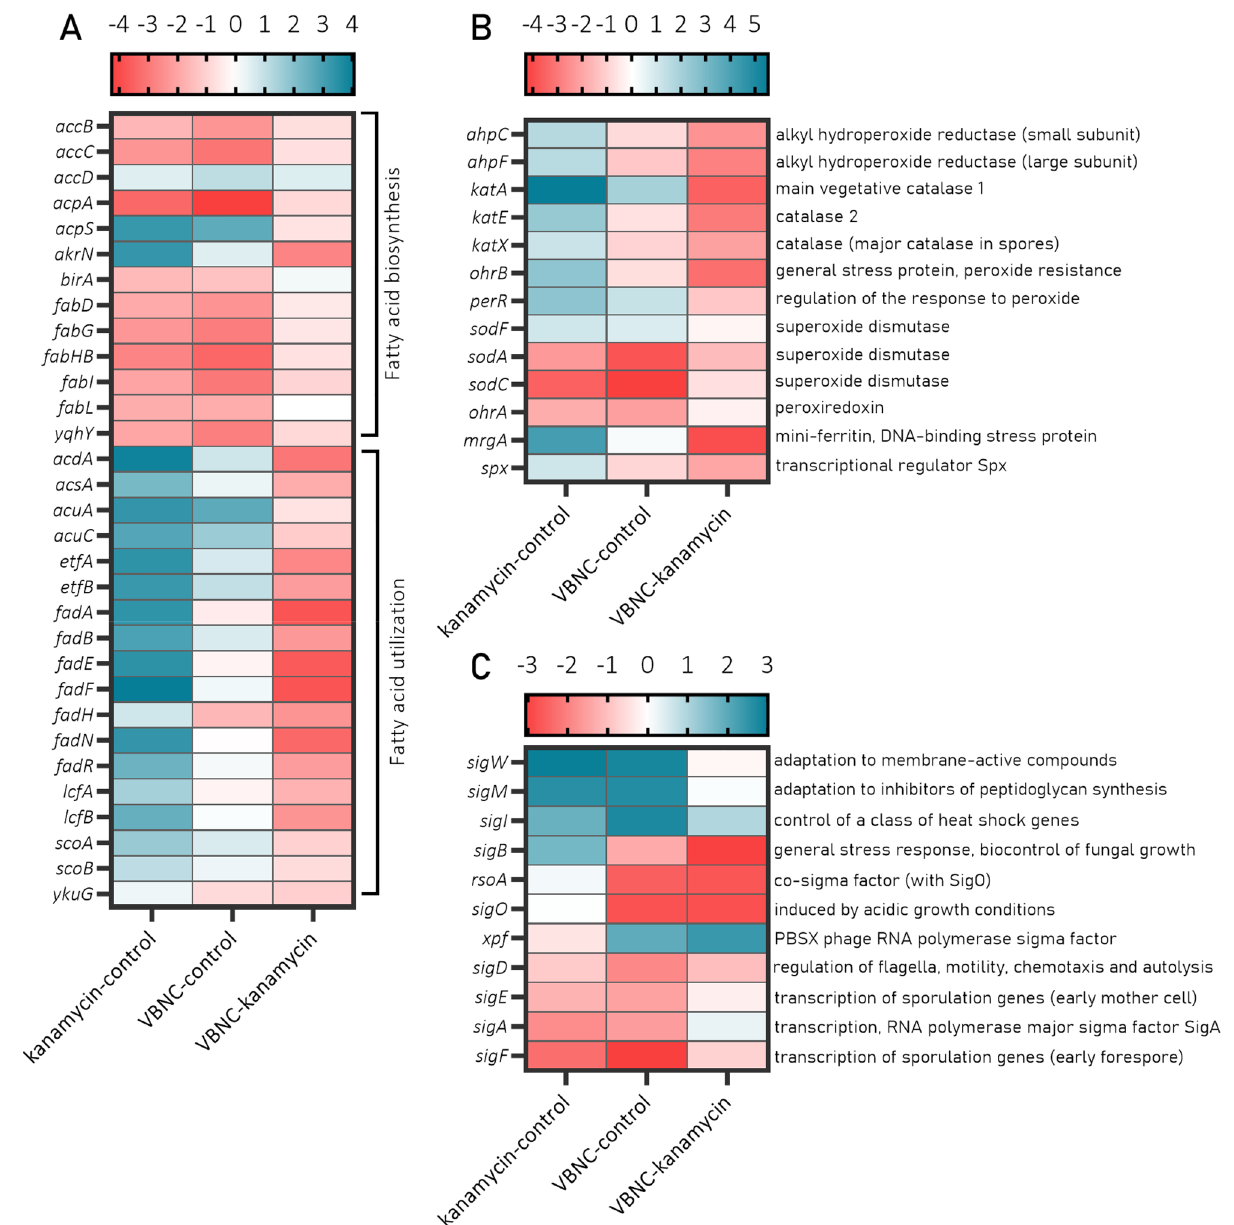
Figure 8. TopHit DEGs for genes involved in fatty acid biosynthesis, oxidative stress and transcription factors in B. subtilis VBNC and kanamycin-sensitive cells. Heatmaps of DGEs ratio values ( p value ≤ 0.05 and a log 2 FC ≥ 2) for ( A ) fatty acid biosynthesis genes, ( B ) genes encoding for oxidative agents detoxification and ( C ) expression levels of transcription factors. The analysis shows significant changes in the gene expression in at